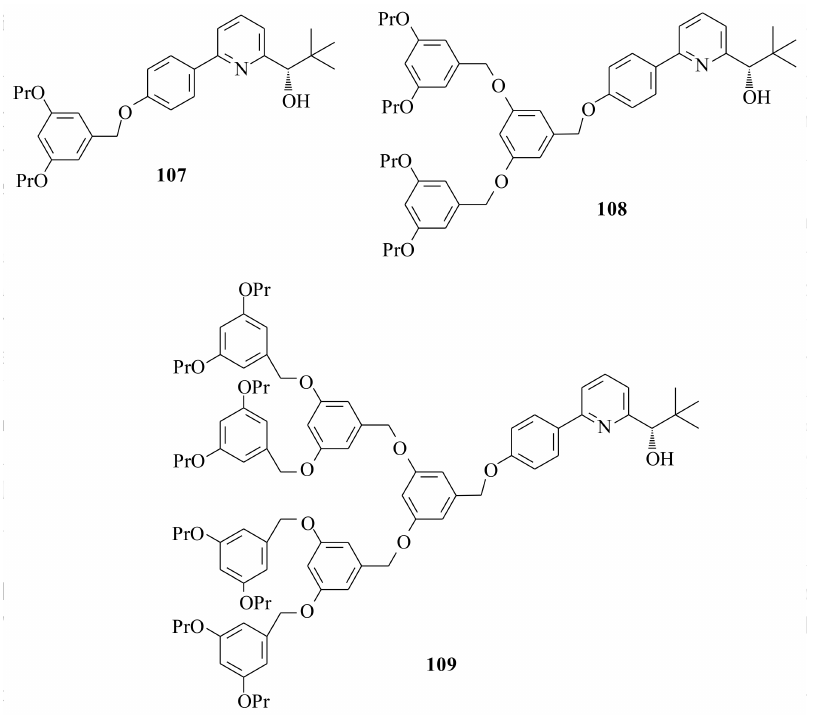
Figure 21. Dendrimeric pyridinyl alcohol